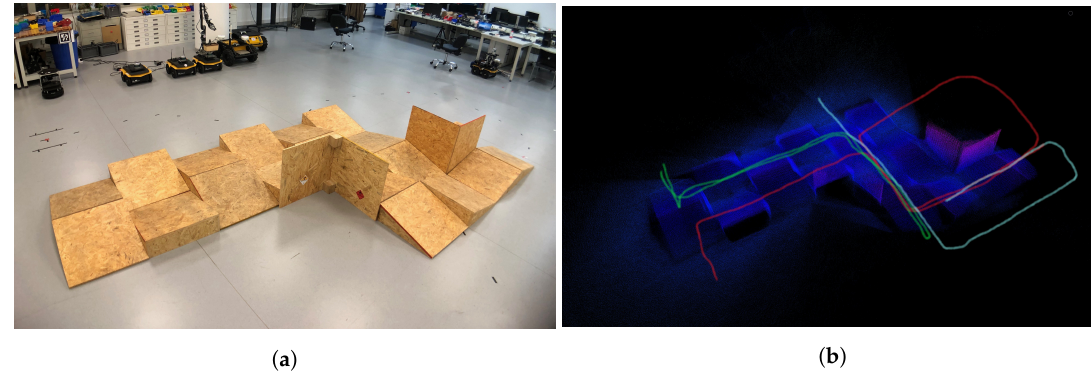
Figure 16. Tracked robot experiment site. ( a ) Real Trajectory Testing Environment; ( b ) Hand-drawn trajectories of the tracked robot experiments. Tracked 1: light-blue; Tracked 2: green; Tracked 3: red.